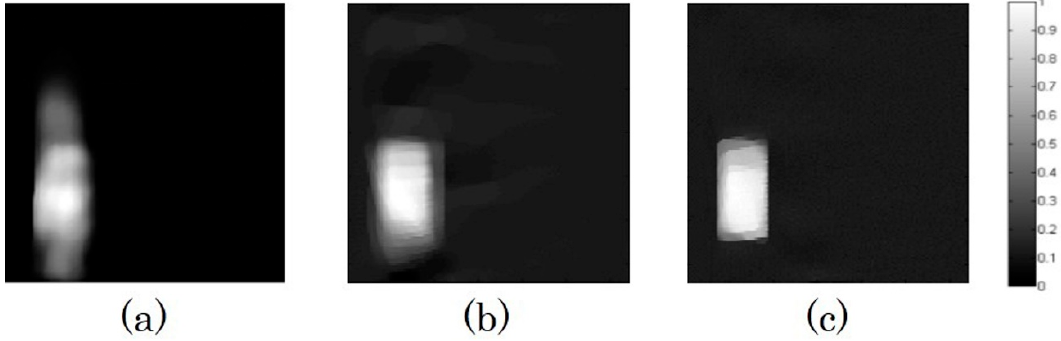
Figure 14. The reconstructed images from the phantom in Figure 10b: ( a ) TV-GD; ( b ) TV-VB; and ( c ) TV-GPEF algorithms for the straight-line scanning.